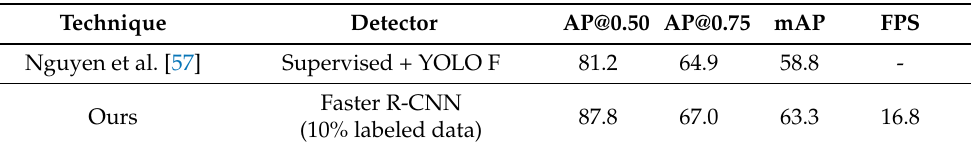
Table 10. Performance comparison of YOLO F baseline model trained on fully labeled data with our model which is equipped with Faster R-CNN and ResNet50 and is trained on 10% labeled IIIT-AR-13K dataset.